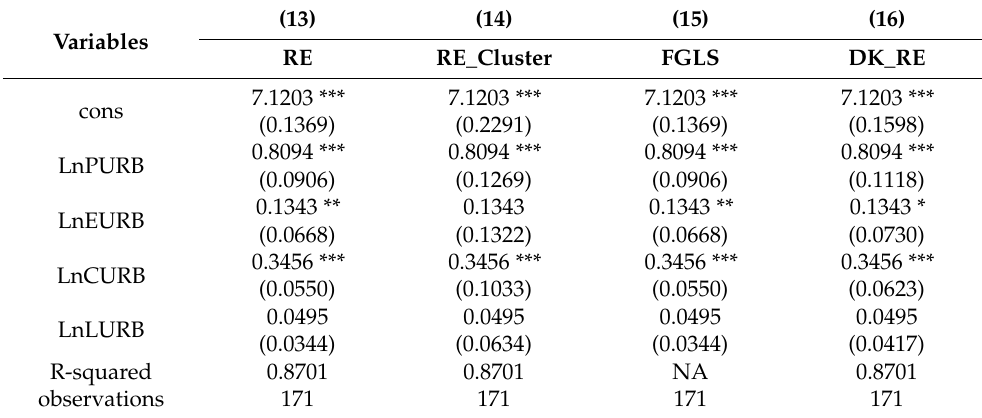
Table 13. Estimation results of western China’s panel